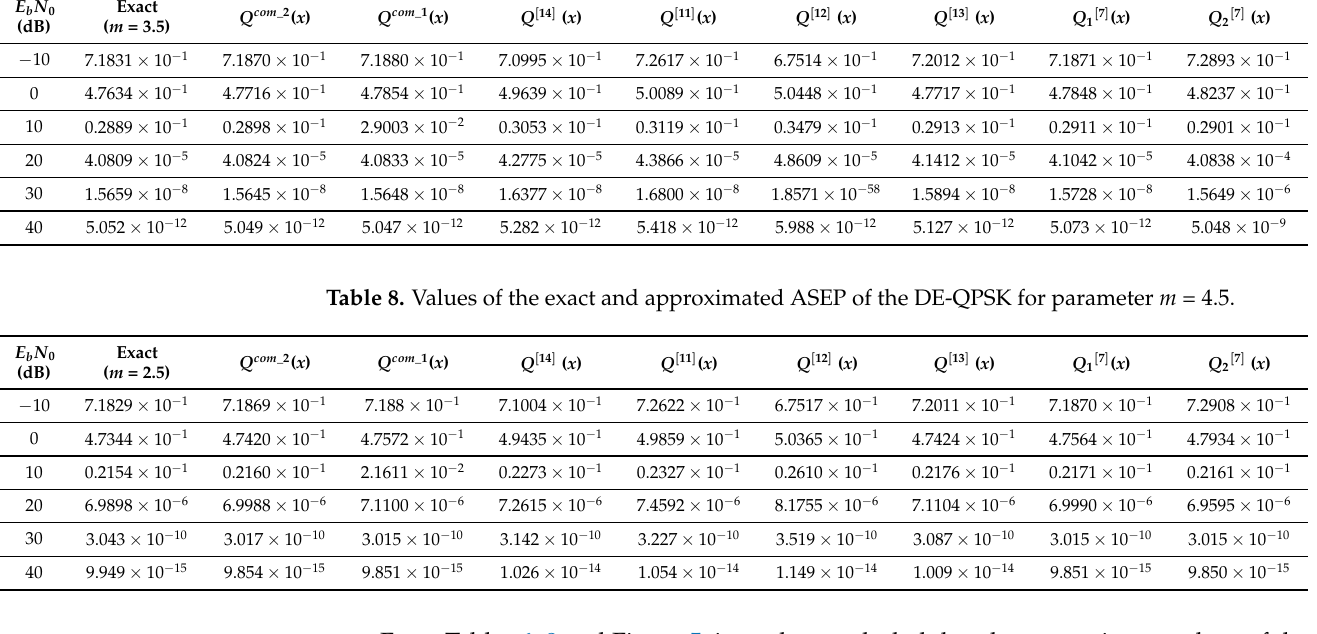
Table 7. Values of the exact and approximated ASEP of the DE-QPSK for parameter m = 3.5. E b N 0 (dB)